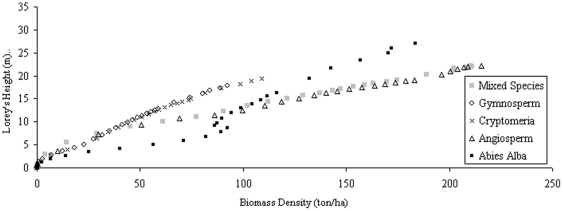
HLorey against stem biomass density for planting densities of 10,000 ha−1.